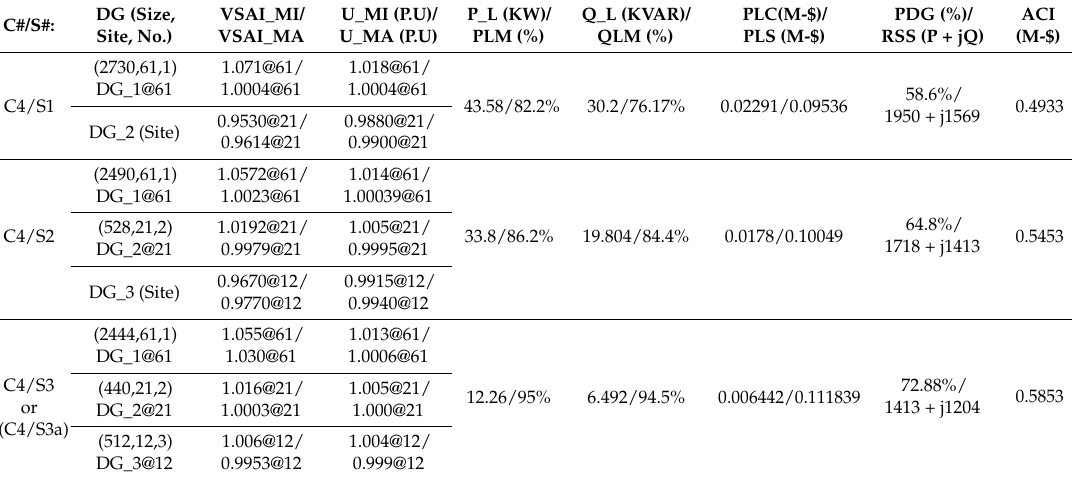
Table 6. Results of proposed planning approach under Case 4 (69-bus-MDS) aim at